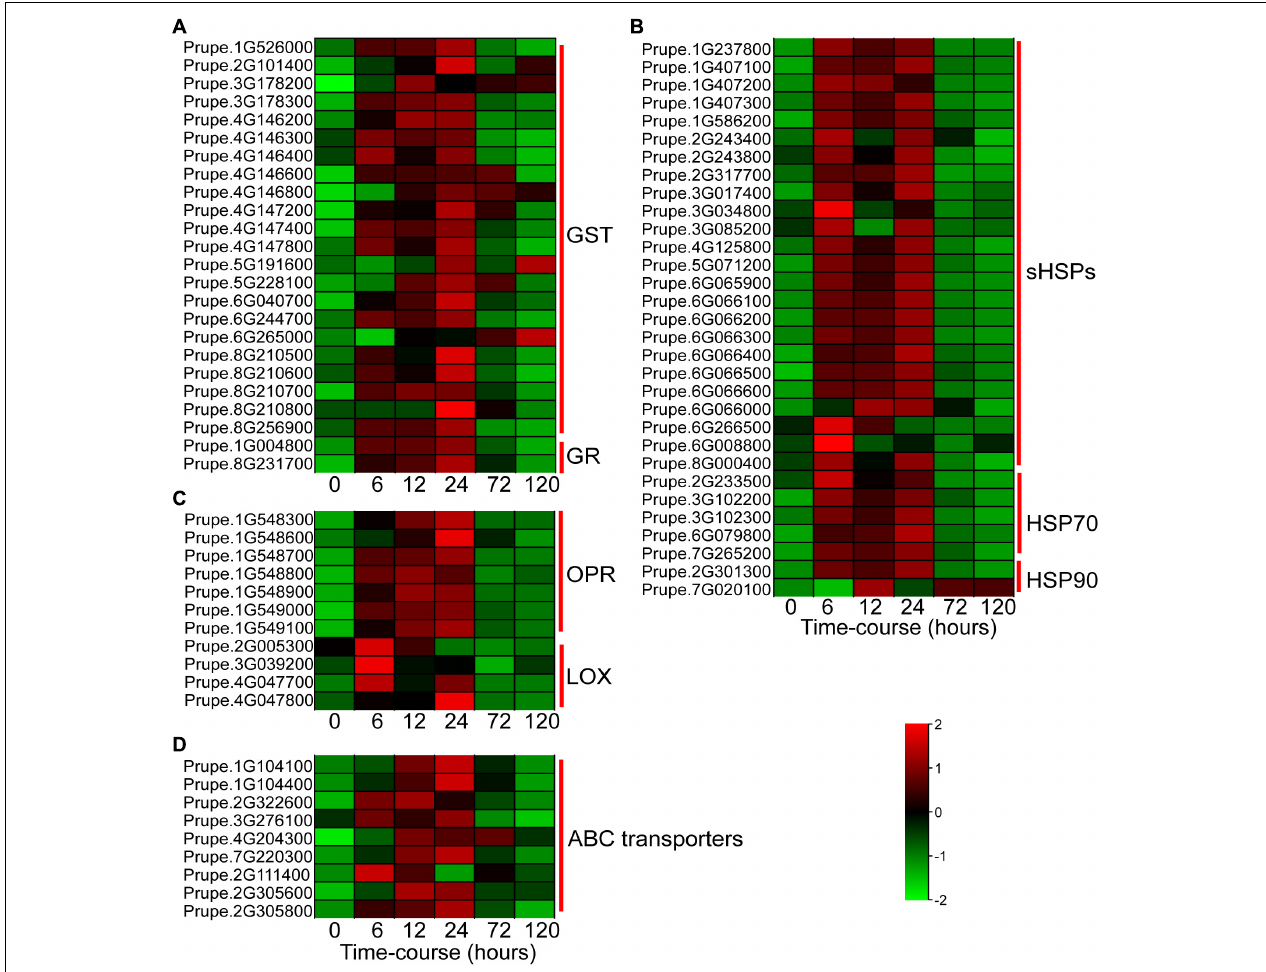
FIGURE 4 | Heatmap showing the expression profiles of DEGs involved in BA stress response. (A) DEGs involved in glutathione metabolism. GST, glutathione S-transferases; GR, glutathione reductase. (B) DEGs related to protein processing in endoplasmic reticulum. sHSPs, small heat shock proteins; HSP, heat shock protein. (C) DEGs associated with α -linolenic acid metabolism. OPR, 12-oxophytodienoate reductase; LOX, lipoxygenase. (D) DEGs encoding ABC transporters. ABC transporters, ATP-binding cassette transporters. The colors of heatmap cells indicate scaled gene expression levels across different samples. The color from green to red indicates that the levels of gene expression gradually